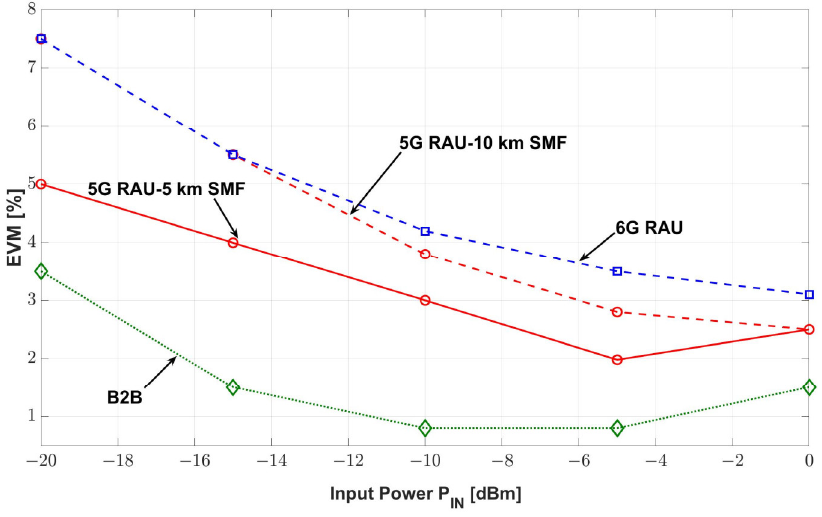
Figure 7. EVM vs. RF input power for 5G (B2B, 5 km and 10 km SMF length) and 6G signals at respective RAUs.